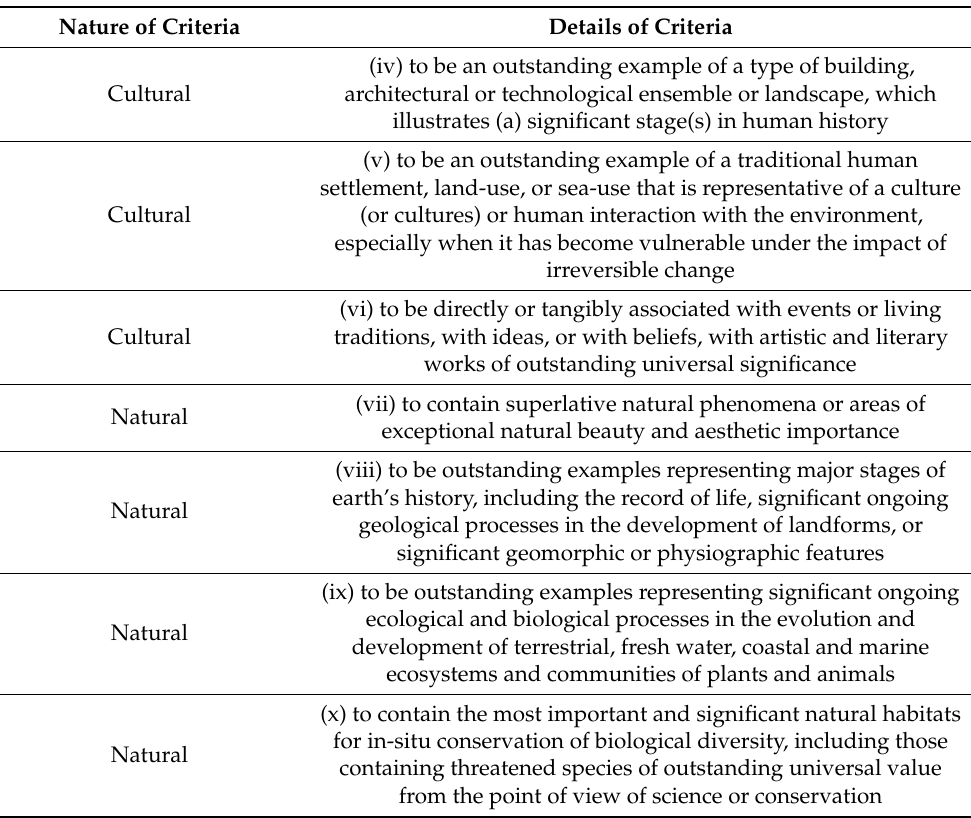
Table 1. Cont . Nature of Criteria Details of